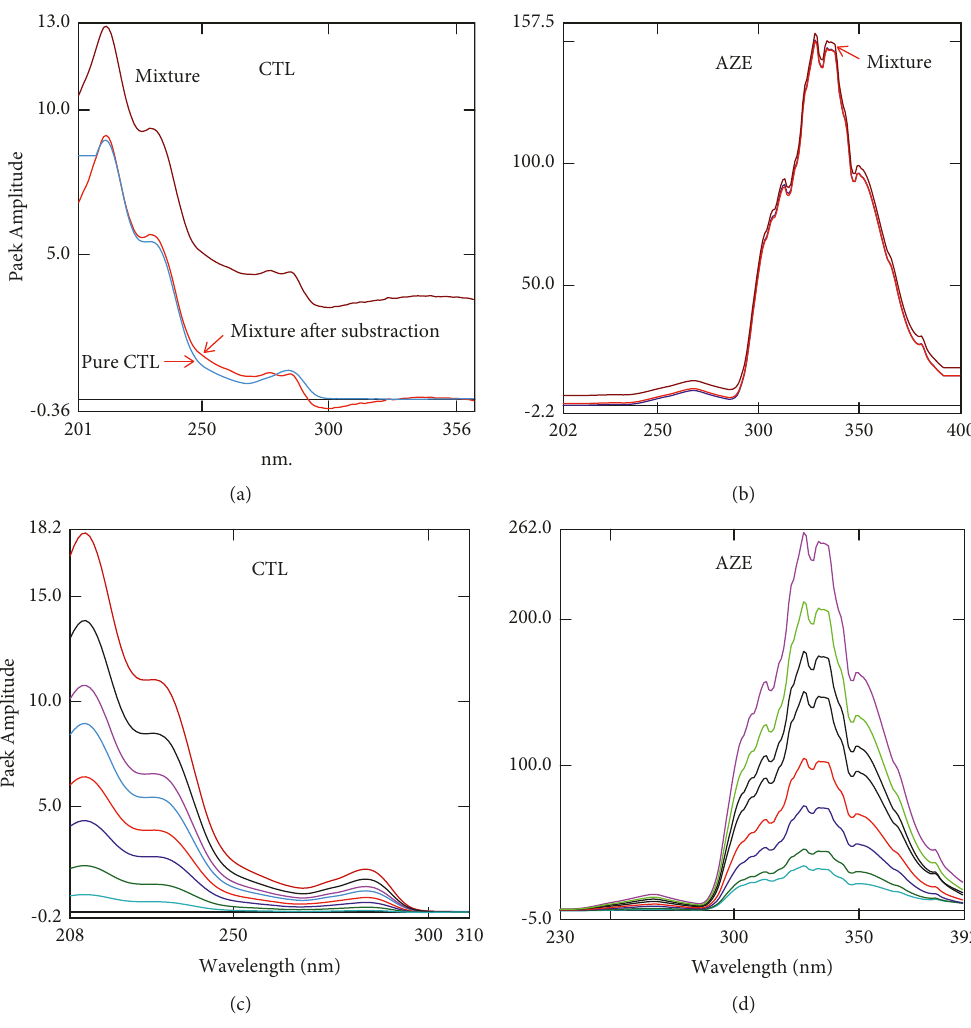
Figure 3: (a) A comparison of ratio spectra generated from pure CTL and mixture of CTL+AZE. (b) A comparison of ratio spectra generated from pure AZE and mixture of CTL +AZE (b). (c) Ratio spectra of CTL 1–15 μ g/mL. (d) Ratio spectra of AZE 1–15 μ